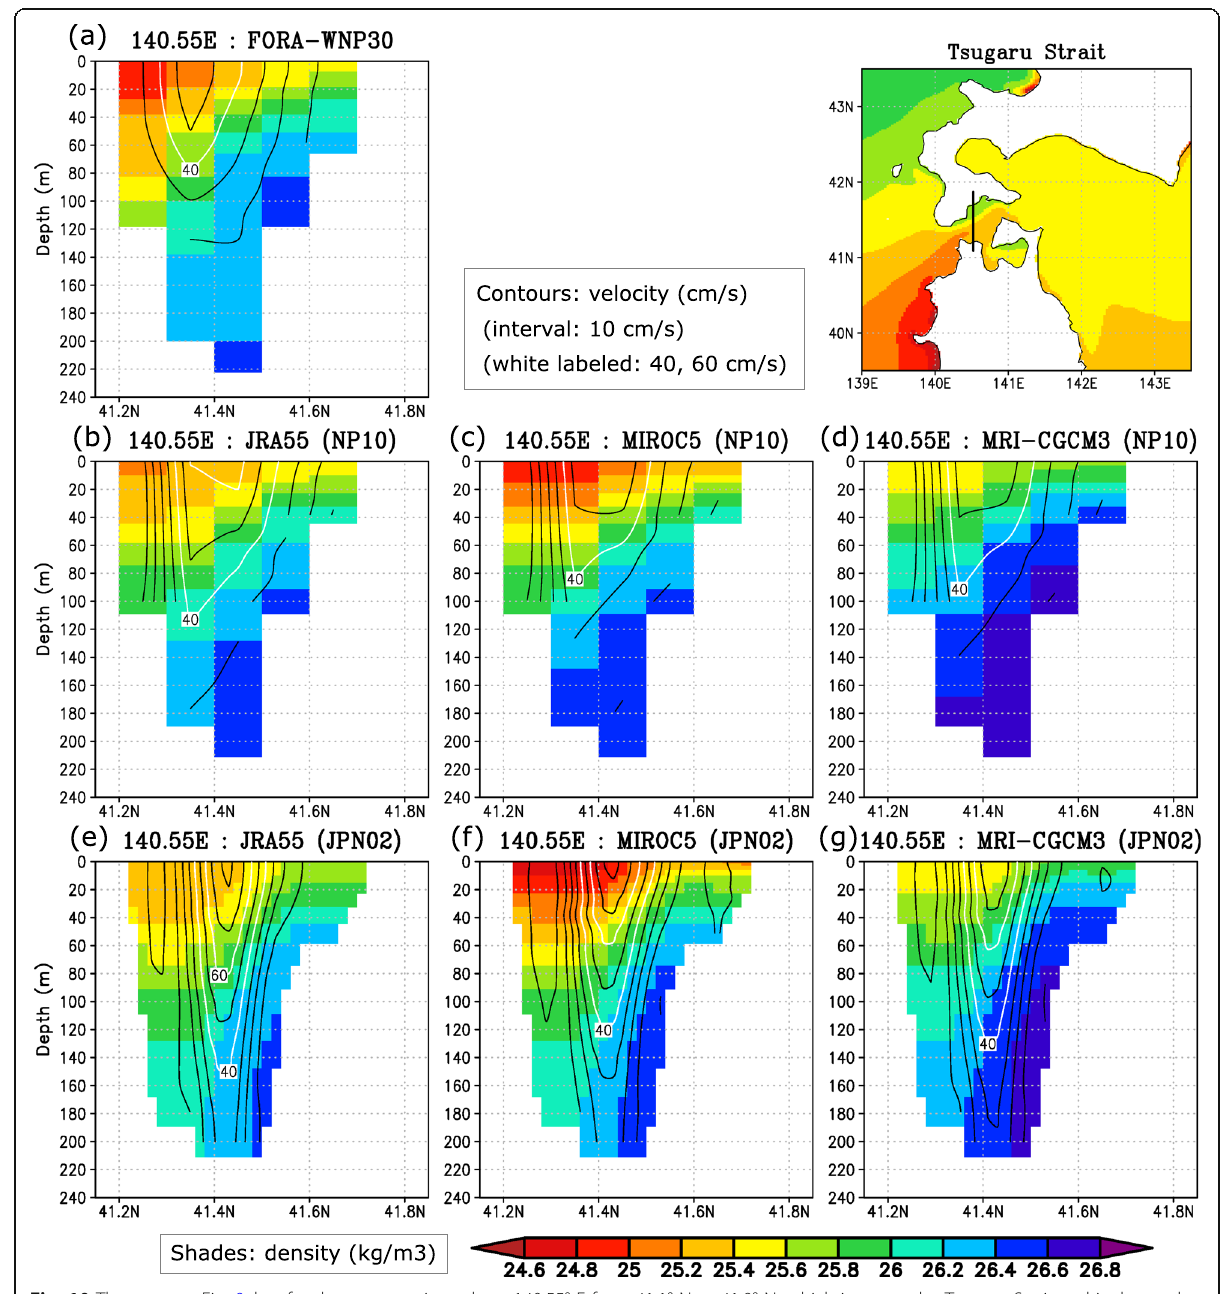
Fig. 10 The same as Fig. 9, but for the cross-sections along 140.55° E from 41.1° N to 41.9° N, which is across the Tsugaru Strait and is denoted by the thick black line in the top-right panel (the surface density map from the JRA-55 forced result of the JPN02). The CI of the zonal velocity in panels ( a ) – ( g ) is 10 cm s −